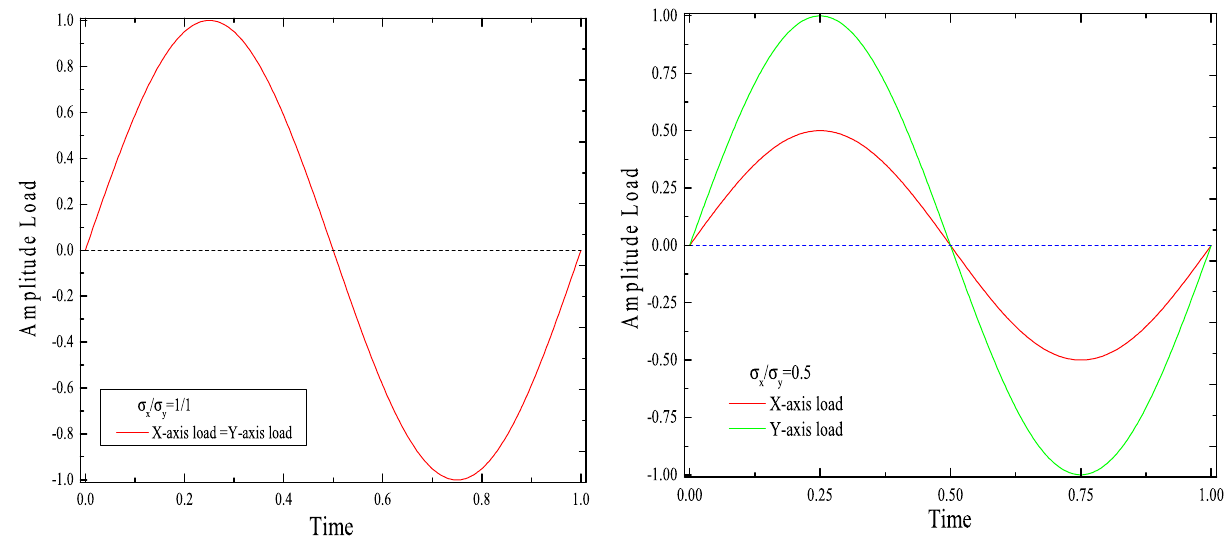
Fig. 3 Applied biaxial loading